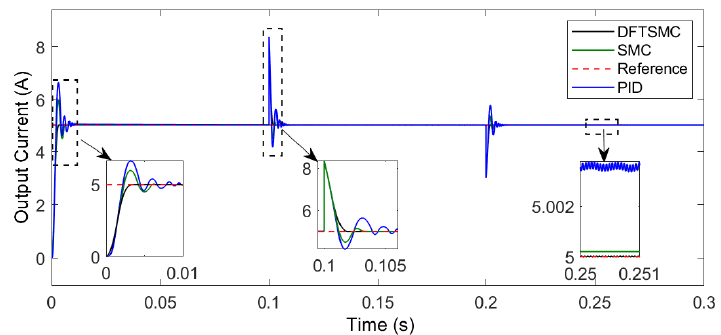
Figure 15. Regulation of output current, I out , during perturbation in R L .